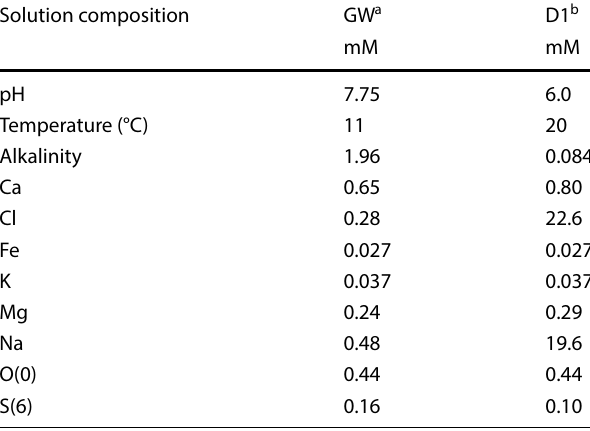
Table 4 Solution compositions used in PHREEQC models of groundwater and highway deicing runoff reactions with rock-fill along roadways in